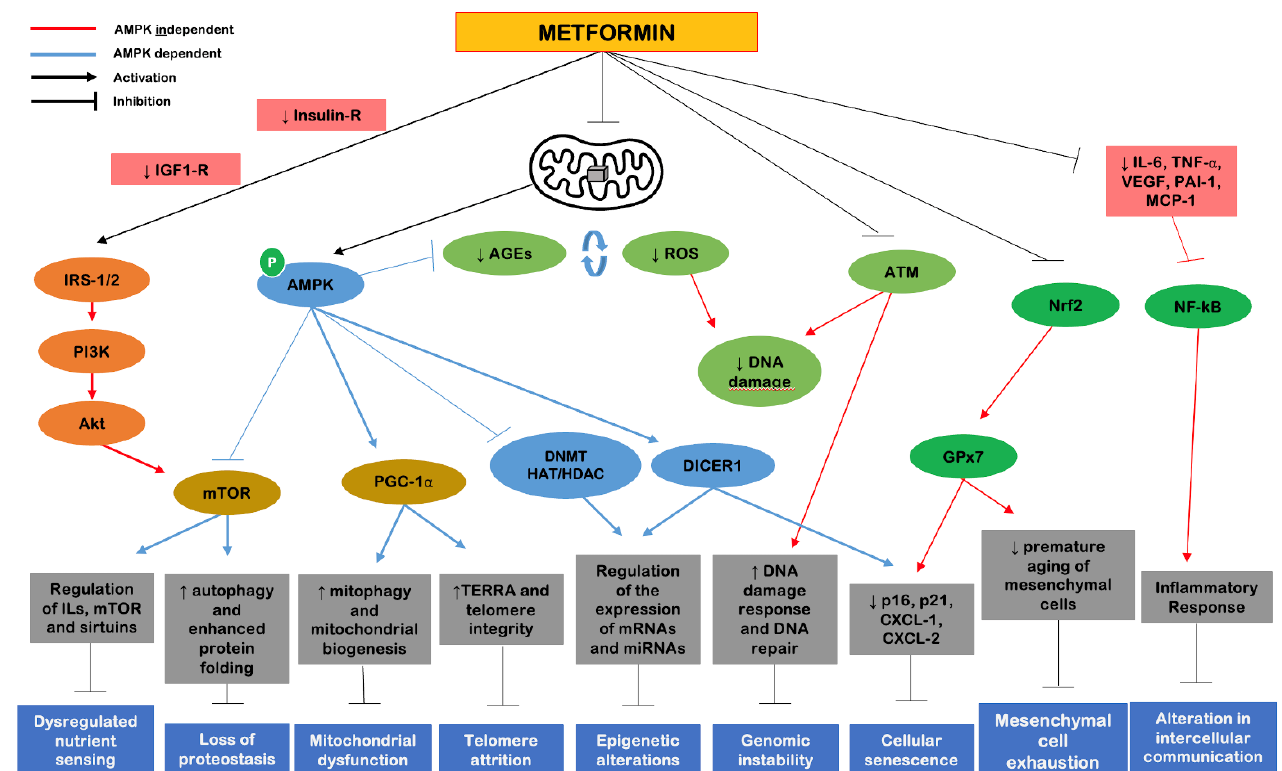
Figure 4. Mechanisms of action of metformin on cellular and molecular markers of aging (adapted from Kulkami et al. [33]). The red lines in the figure represent AMPK-independent mechanisms. The blue lines represent AMPK-dependent mechanisms. The inhibitory capacity of the molecular elements is given by the lines ending with a bar, while the arrows refer to the capacity for stimulatory action. Abbreviations: AGEs, advanced glycation end products; Akt, protein kinase B; AMPK , 5'adenosine monophosphate-activated protein kinase; ATM, ataxia-telangiectasia-mutated; CXCL-